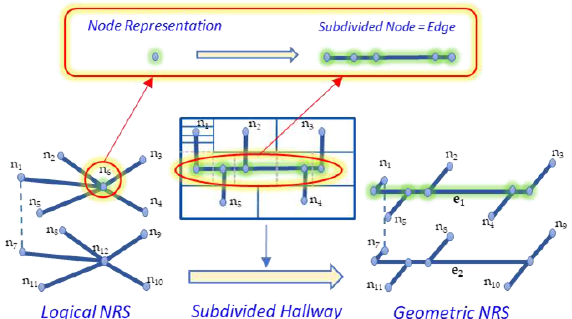
Figure 3. Generating lower-level (more detailed) Geometric NRS through space